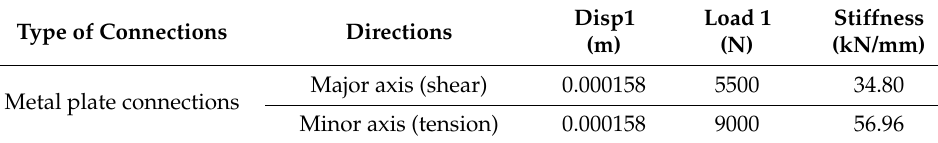
Table 3. Connections parameters for metal plate connections.